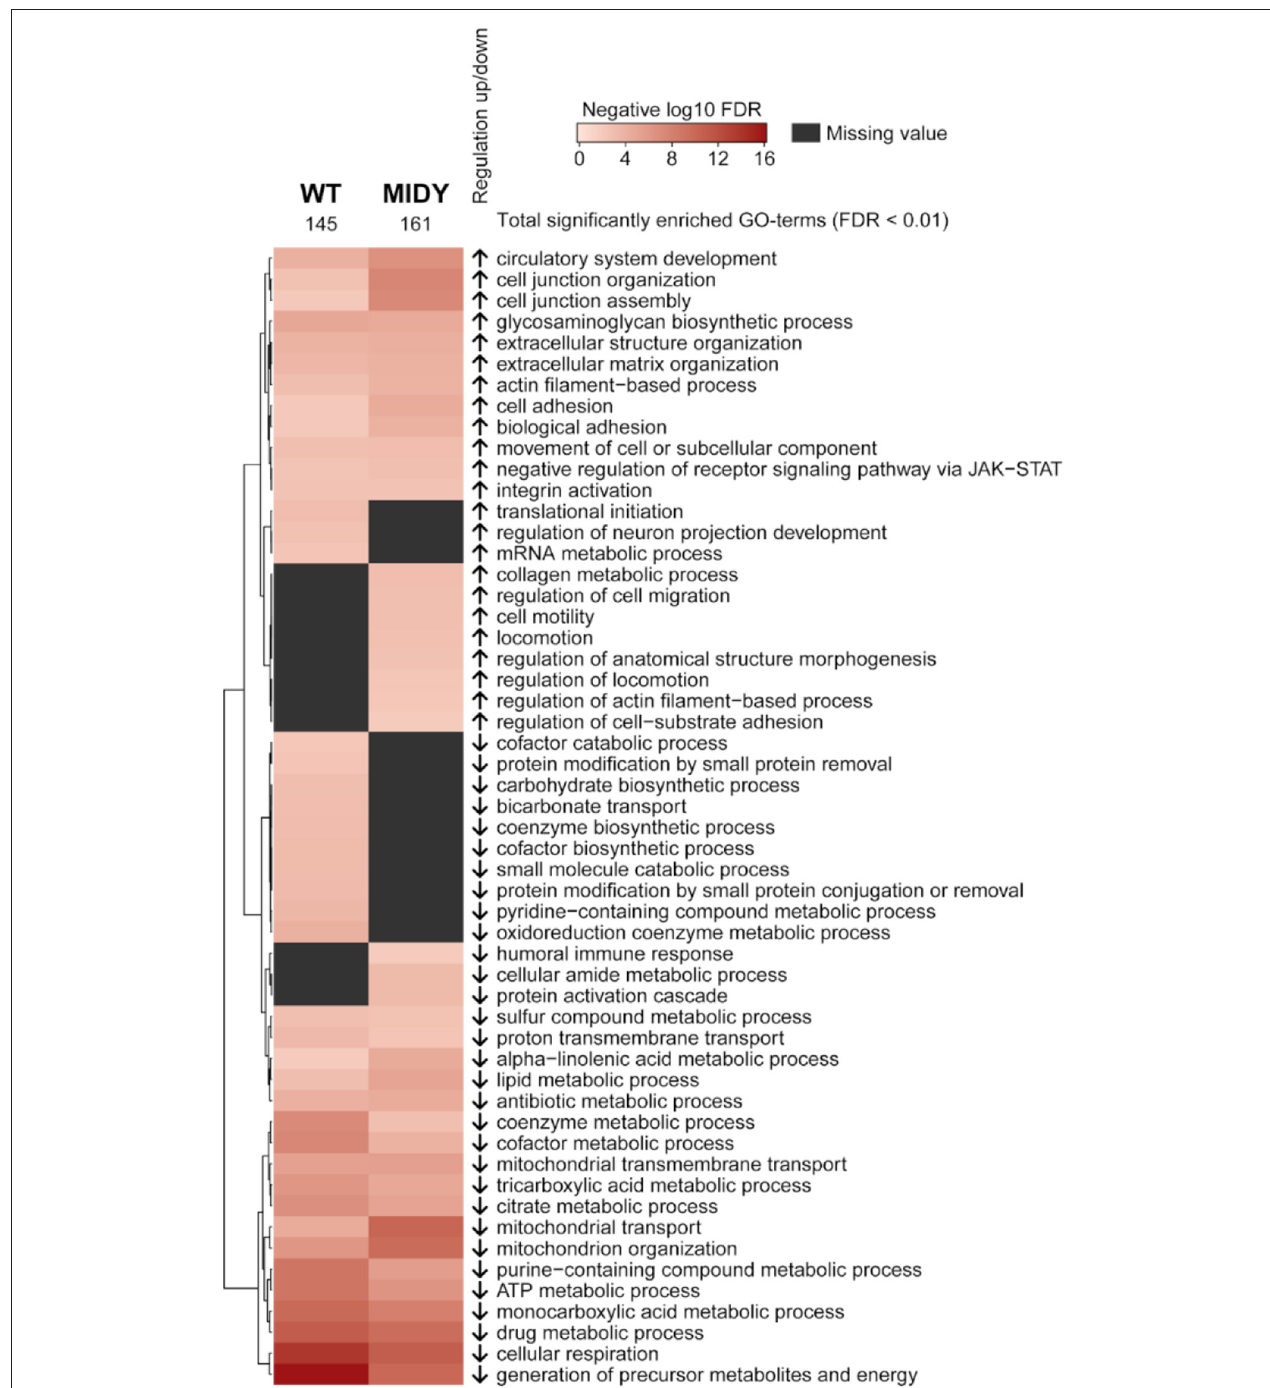
FIGURE 2 | Functional characterization of adipose tissue depot differences between MAT and SCAT in WT and MIDY animals. Heatmap shows GO-term enrichment in SCAT compared to MAT. Enrichment analysis was performed using a pre-ranked STRING analysis and an FDR cutoff of 0.01. Significantly enriched GO biological processes were summarized with REVIGO by grouping semantically similar ontology terms. Arrows indicate regulation in SCAT. 5 ). Similar ontology terms were revealed with REVIGO (44) GO biological processes database, 145 and 161 terms were found in WT and MIDY, respectively, to be significantly enriched and the resulting clusters are visualized in Figure 2 . SCAT (FDR < 0.01) in SCAT vs. MAT ( Supplementary Tables 4 , from WT and MIDY animals showed, among others, a